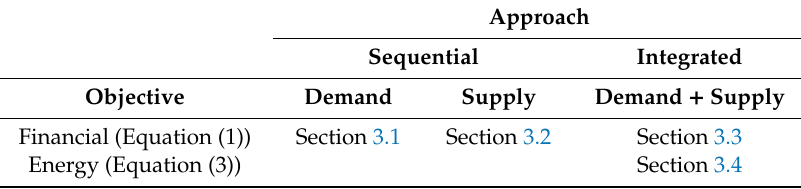
Table 4. Summary of optimization runs and sections for results